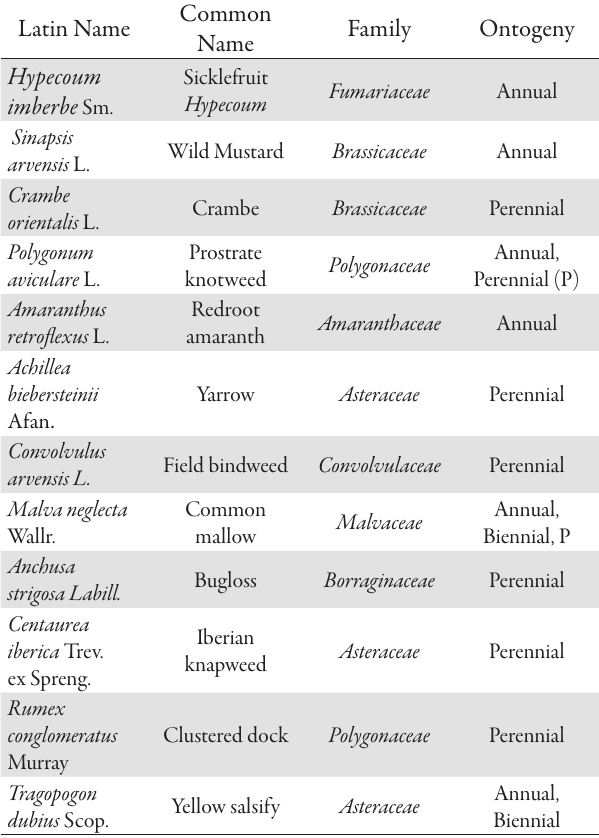
Tab. 1. Latin, common and family names and ontogeny of